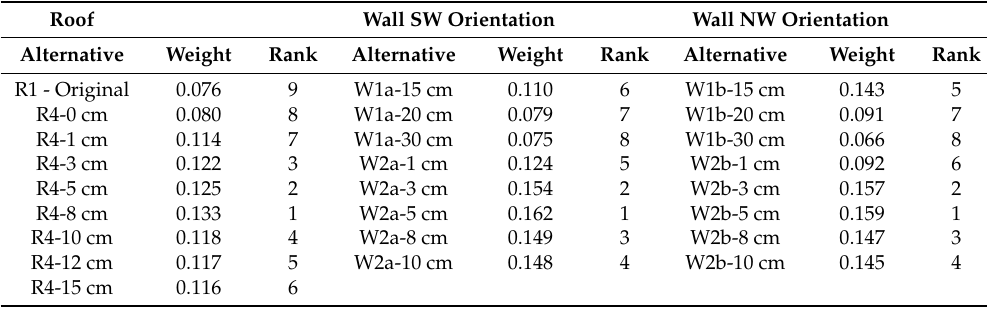
Table 14. Global priority vector for different insulation thicknesses.